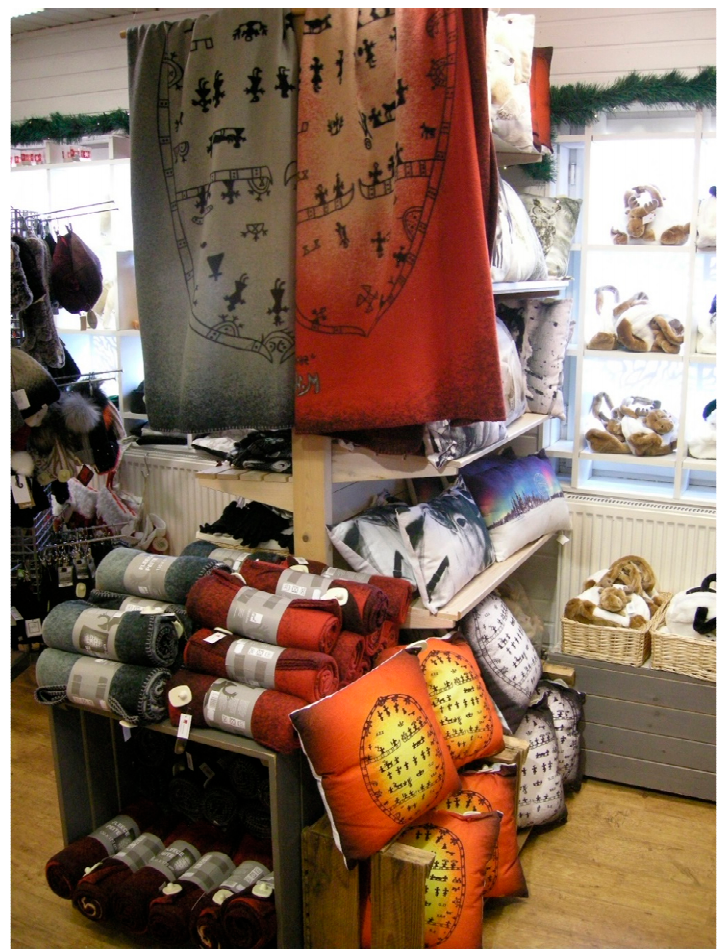
Figure 2. ‘Rugs and pillows with motifs from Sámi Noaidis divination drums in a souvenir shop in Roavvenárga/Rovaniemi, Finland June 2019. Photo by the author.